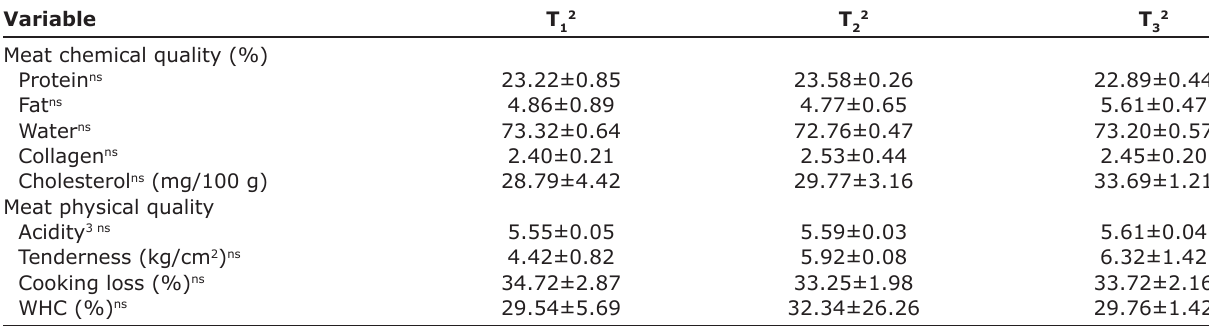
Table-5: Meat chemical and physical quality of male Bali cattle fattened by complete feed containing protein from Gliricidia sepium leaves 1 .